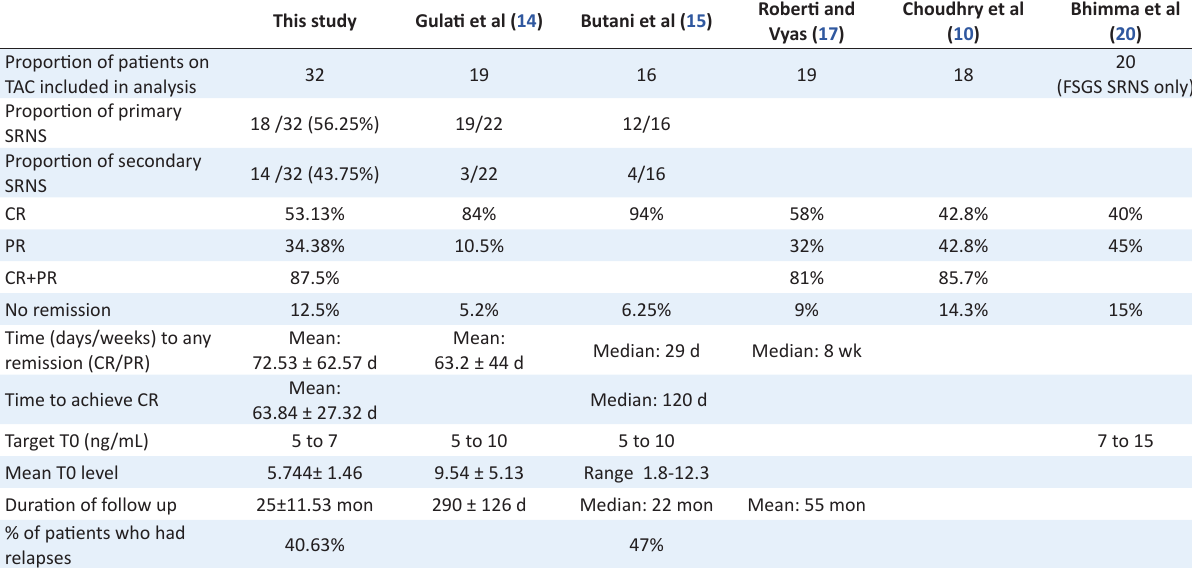
Table 3. Comparison of efficacy of Tac in SRNS in our study with other studies This